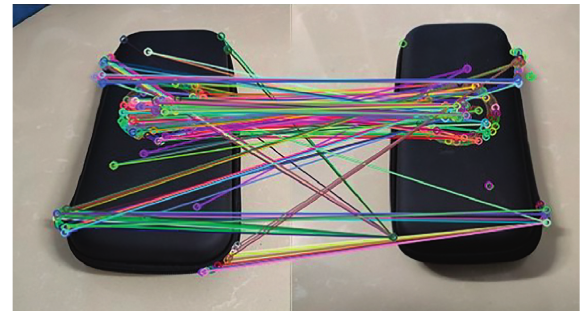
Figure 2: The case of similar